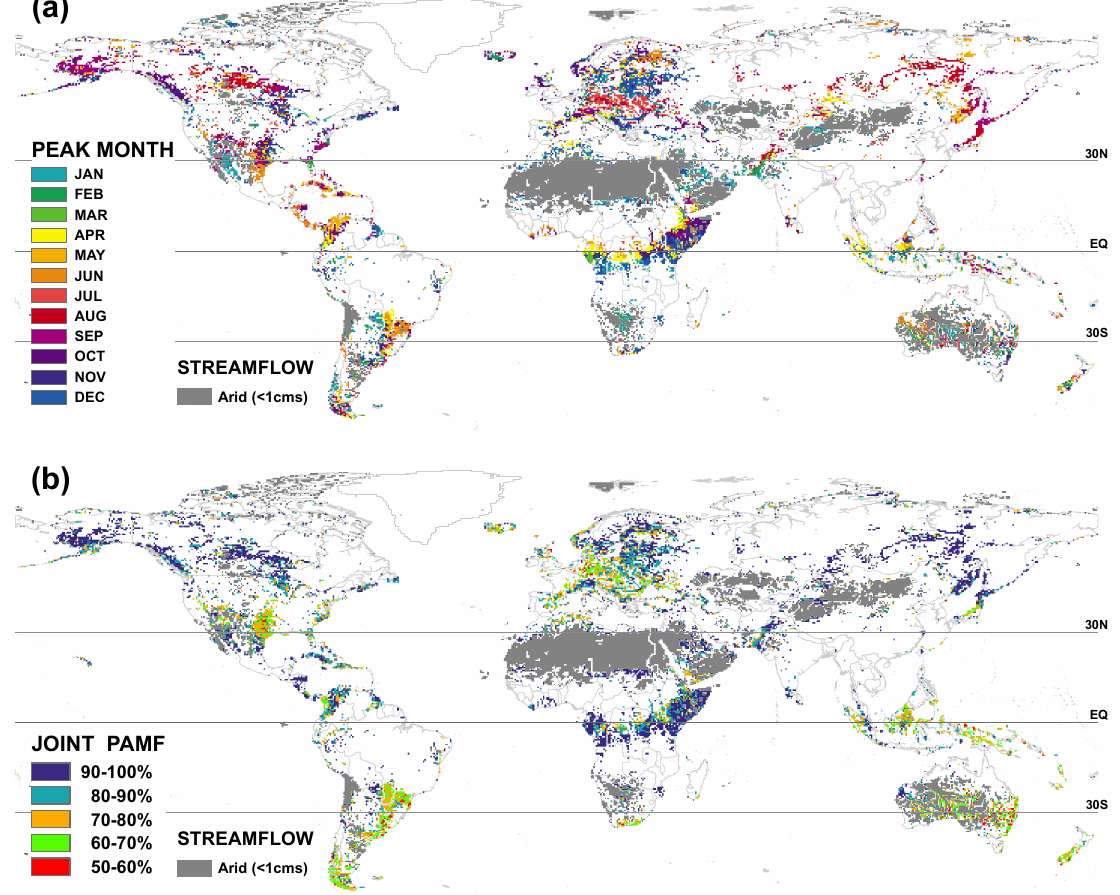
Figure 11. (a) Minor peak month (PM) for flooding as defined at detected grid cells and (b) joint PAMFs of major and minor PMs at corresponding cells; subjectively classified as high (80–100%), moderate (60–80%), and low